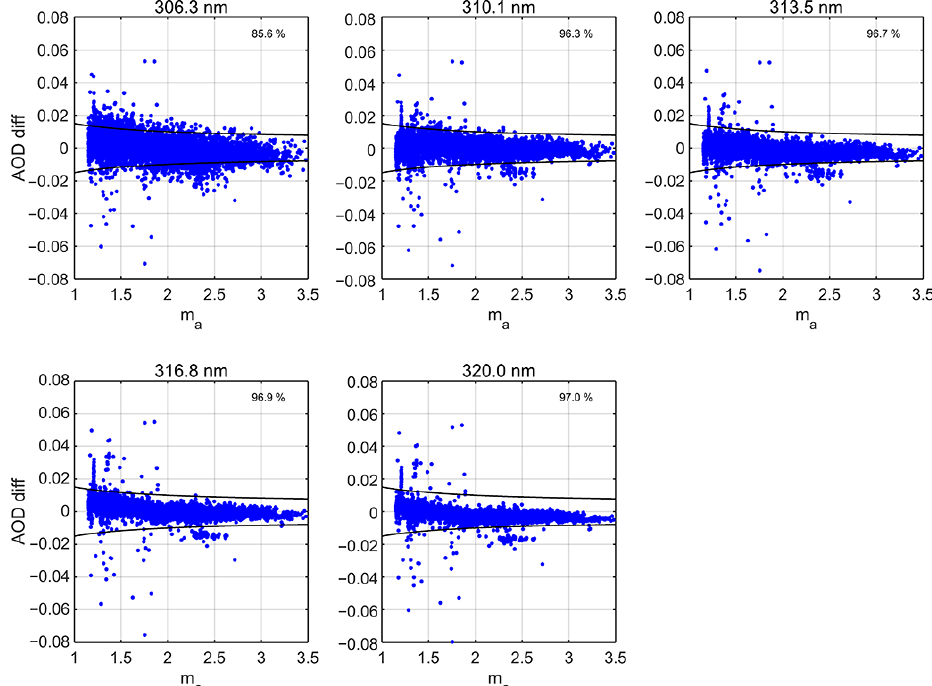
Figure 7. Differences in AOD, UVPFR–Brewer, at Brewer wavelengths for measurements during autumn 2015 and spring 2016 in Davos. Percentage of differences within WMO traceability limits is given in each